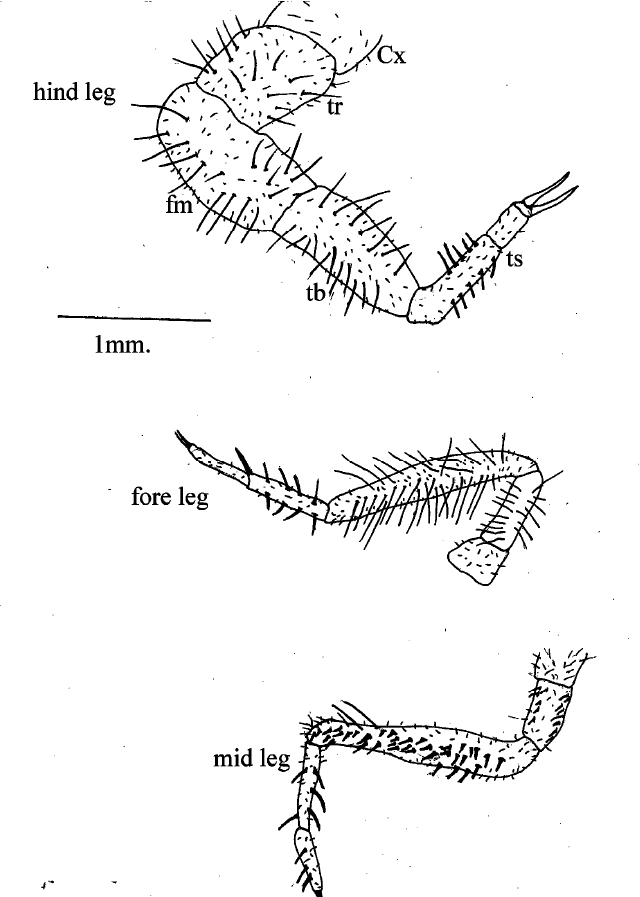
F IG .2.- Legs of the 3 rd instar larva.Cx; Coxa, tr; trochanter, fm; femur, tb; tibia, ts; tarsus. Legs: Each tarsal segment ends to two brown claws .Hind legs more strong and robust and have claws bigger than the two other pairs of legs. On the dorsal and ventral surfaces of legs are long and short spines and bristles (Fig.2.). Abdomen: Small spines and bristles are scattered on the terga and sterna of abdominal segments. On each side of the last abdominal segment, lateral to anus, there are six long black spines, and on mid dorsal part of anus, 27 small spines situated in four rows. Male imago: Length of body without antenna 31mm, head and thorax yellow. Compound eyes dark brown, antennae clavate brown.On epicranium of head is located a cross like dark brown spot; two other quadrate spots are equally situated lateral to it. Pronutum: A median longitudinal dark brown band is located in median part of pronutum, dividing it to two equal sections